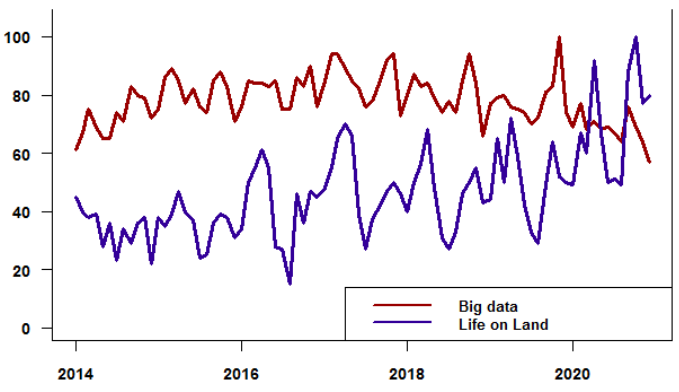
Figure 16. Big Data and SDG 15 global Google trends since